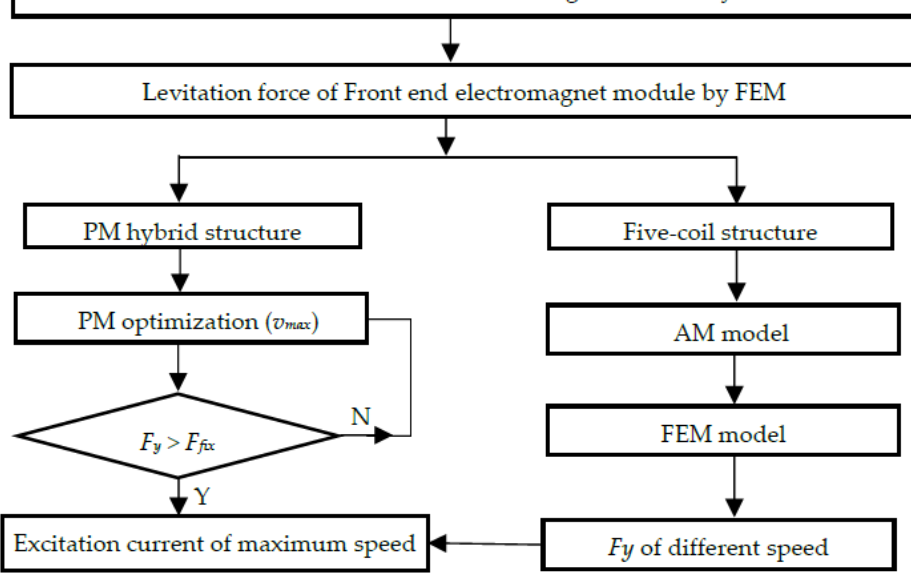
Figure 5. The flow chart of improved structures.